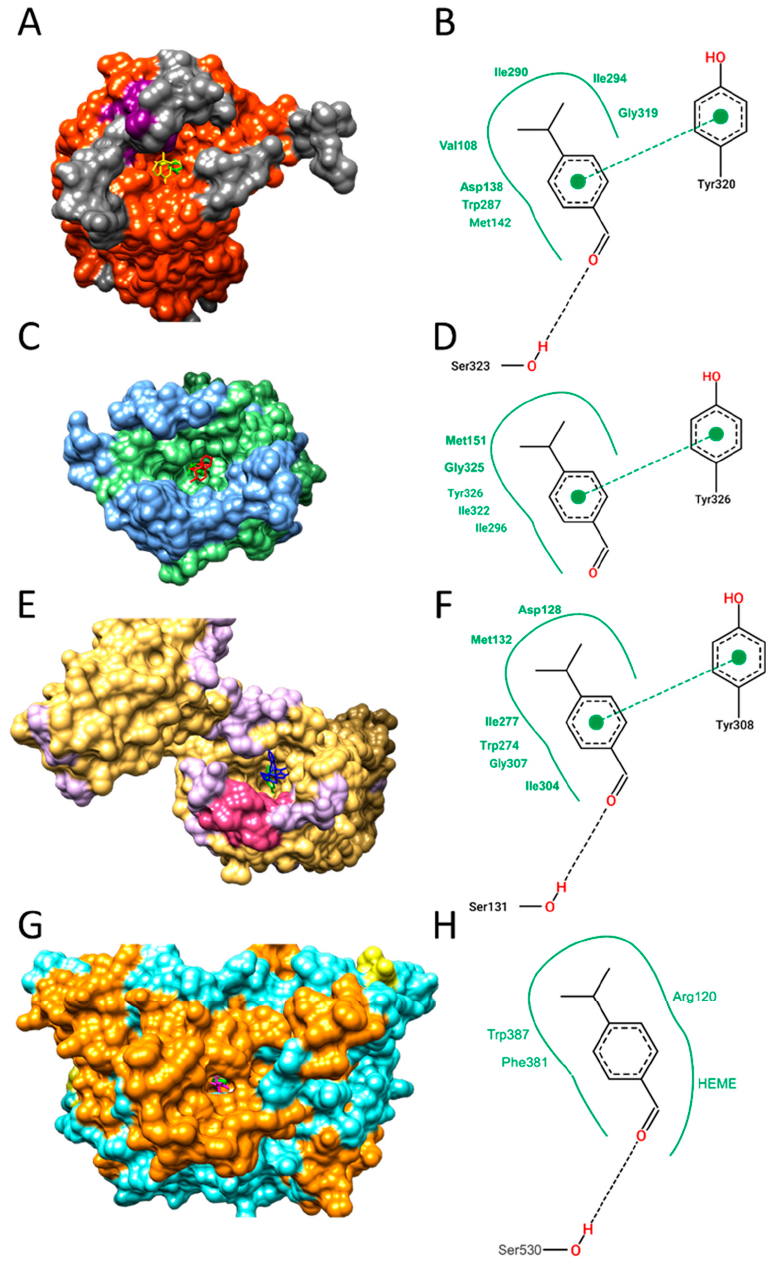
Figure 9. The spatial conformation of kappa, mu, and delta ORs (PDB IDs 6B73, 6DDF, and 6PT3, respectively) and COX-2 interacting with cuminaldehyde (shown in green) is illustrated in panels ( A , C , E , G ), respectively. Panels ( B , D , F , H ) show the two-dimensional diagram of the contacts made by cuminaldehyde with the amino acid residues of the active site of kappa, mu, and delta ORs, and COX-2, respectively, obtained by molecular docking. Traditional opioid drugs, such as CVV (shown in yellow in Figure 9A), morphine (in red in Figure 9C), and naltrindole (in blue in Figure 9E), as well as indometacin (in magenta in Figure 9G) are also depicted. Hydrogen bonds are represented by dashed black lines, van der Waals interactions by full green lines, and π - π interactions by dashed green